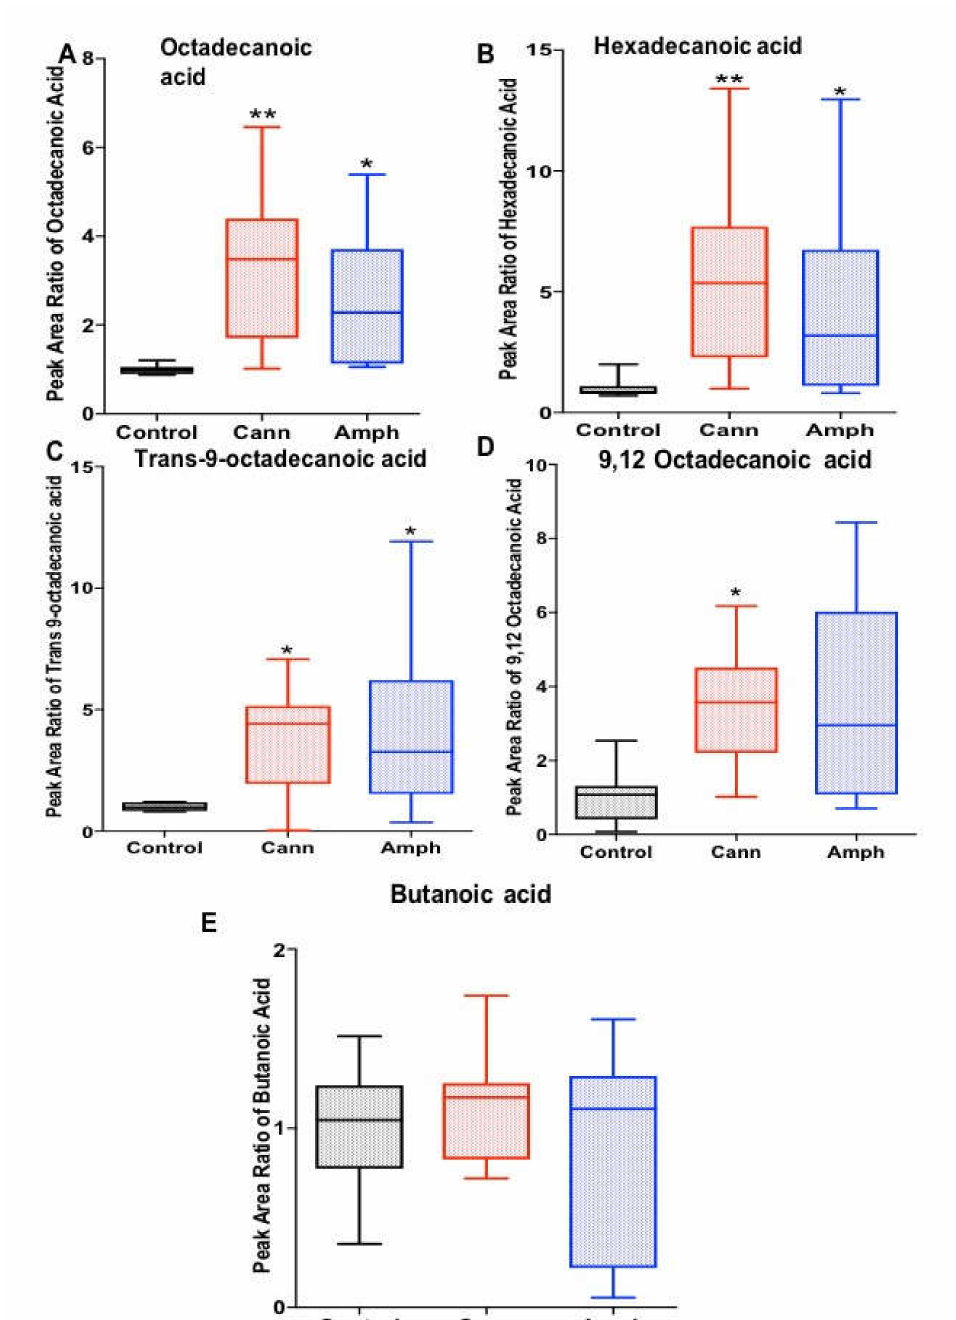
Figure 3. Effects of cannabis or amphetamine on selected fatty acids in cannabis or